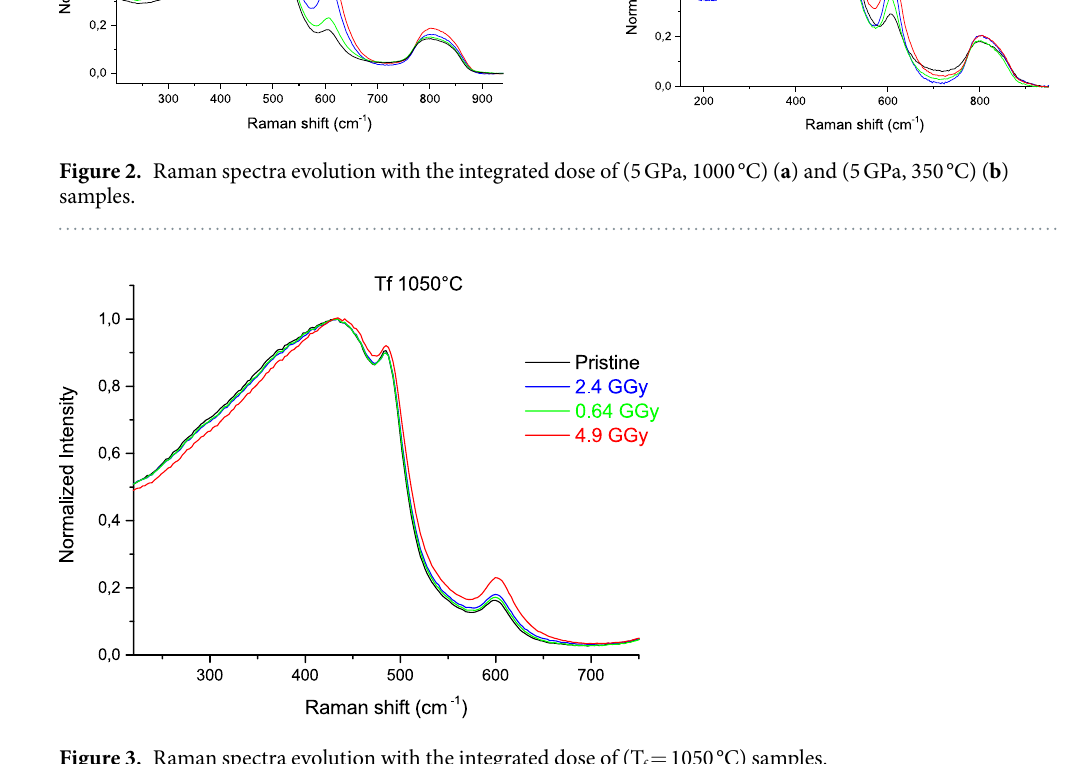
Figure 3. Raman spectra evolution with the integrated dose of (T f = 1050 °C)